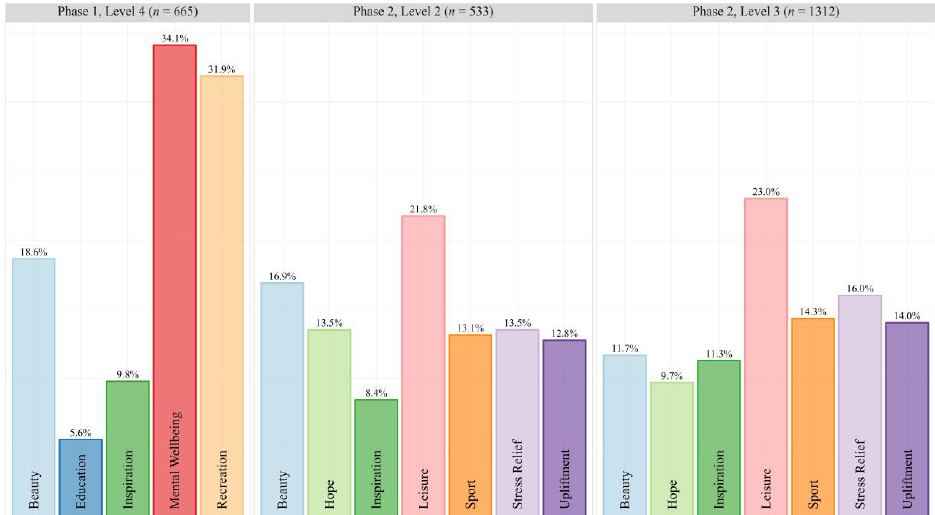
Figure 7. Reasons for visiting Tanera Park during the COVID-19 lockdowns in Wellington. Phase 1 of the jar survey included five options. These options were expanded in phase 2 of the survey and grouped into the categories of mental wellbeing (upliftment, stress relief, and hope), recreation (sport and leisure), and aesthetics (beauty and